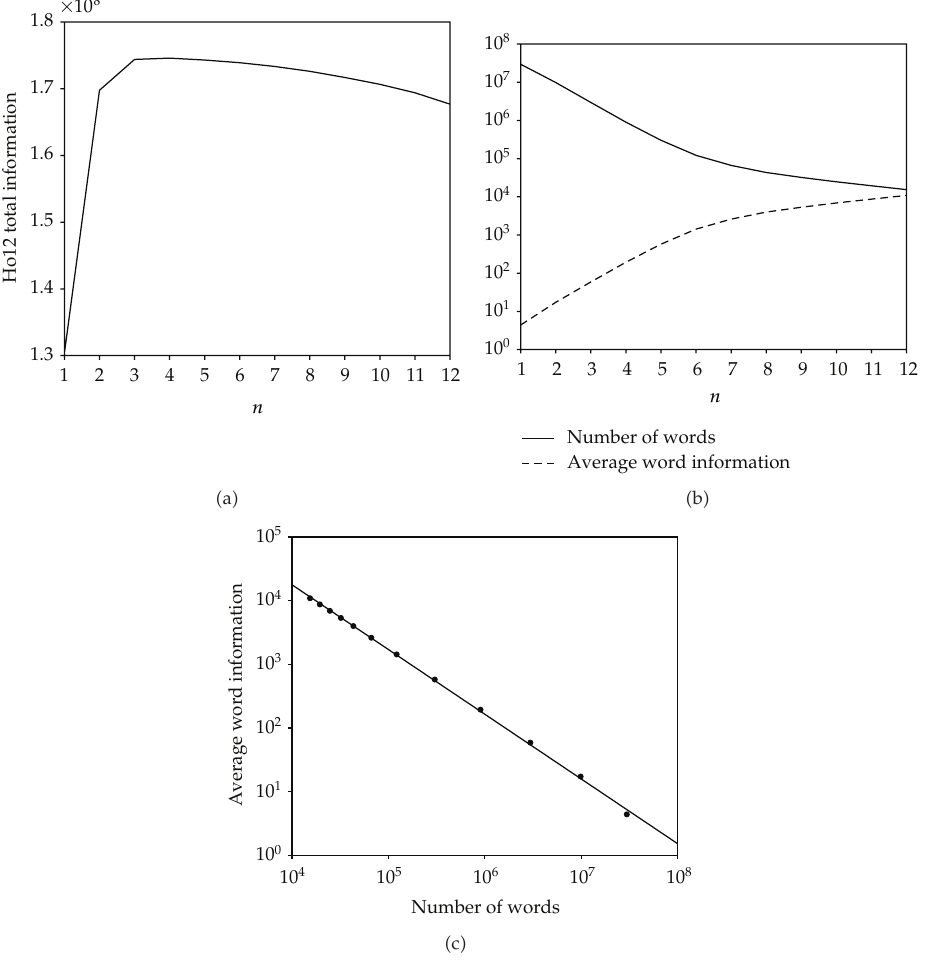
Figure 5: Chromosome Ho12: (cid:5) a (cid:6) total information versus n , (cid:5) b (cid:6) average word information and number of words versus n , (cid:5) c (cid:6) average word information versus number of words. b (cid:7) − 1 . 02. For the rest of the chromosomes it was observed a similar type of behavior, but with di ff erent numerical values for the